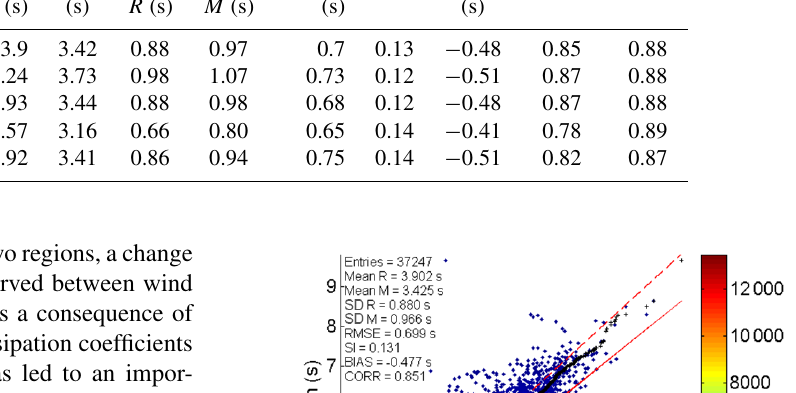
Table 6. Med-waves T m evaluation against wave buoys’ H s , for the full Mediterranean Sea, for a 1-year period (2014) and seasonally. MED Entries